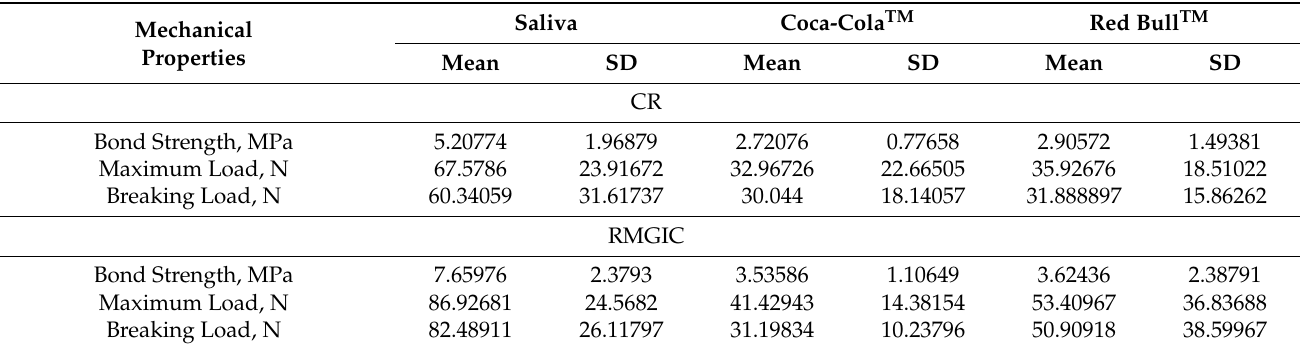
Table 1. Shear bond test